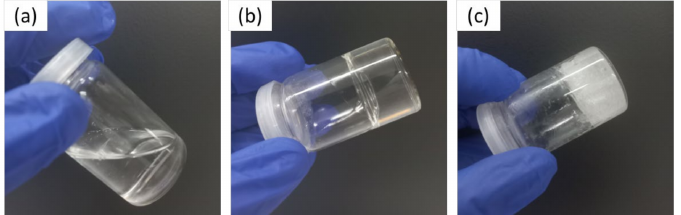
Figure 3. Images of Pluronic F127:F68 at 17:3 ratio: ( a ) 0 wt.% of microparticles at 21 ◦ C, ( b ) 0 wt.% microparticles at 37 ◦ C and ( c ) 15 wt.% microparticles at 37 ◦ C.